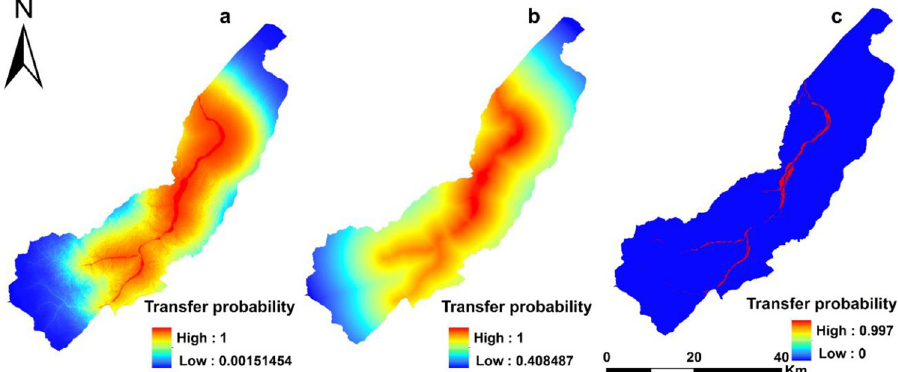
Fig 6. Transition probability of rural settlements in QPT. (Software: ArcMap 10.2.0, http://www.esri.com. Figures were generated with ESRI using author-owned data).